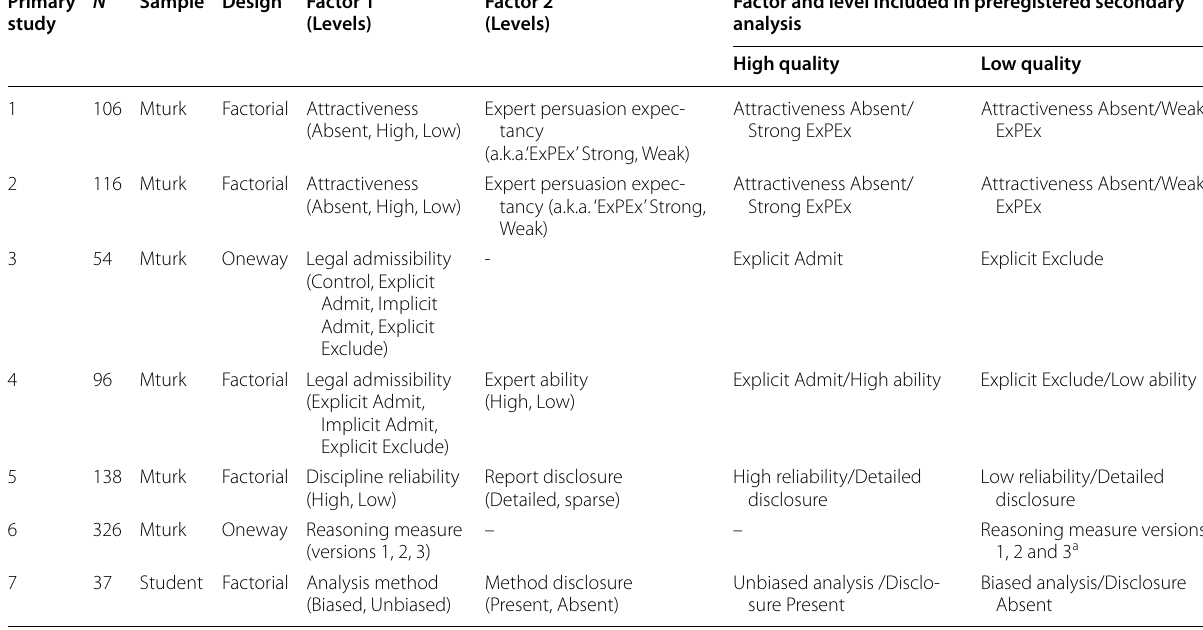
a All participants in Study 6 evaluated a low-quality (flawed) expert report prior to receiving the experimental manipulation